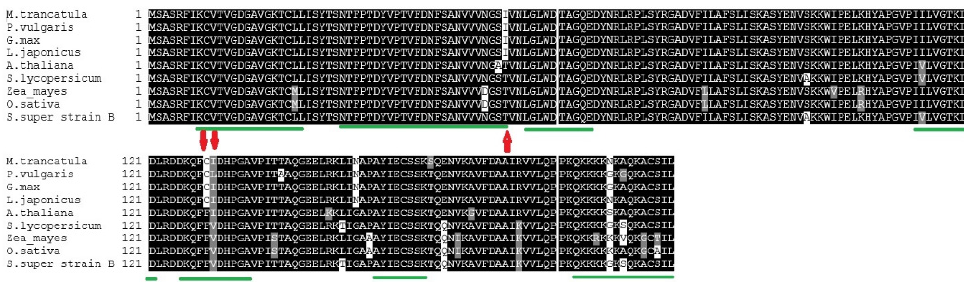
Figure 3. Multiple sequence alignments and the proteins of S. lycopersicum super strain B (ROP9) and those retrieved from the genomic databases: A. thaliana (At2g17800), O. sativa (LOC_Os02g58730), S. lycopersicum (Solyc02g083580), Z. mays (GRMZM2G375002), L. japonicus (chr2.CM0272.860.r2.m), M. truncatula (Medtr4g064897), P. vulgaris (Phvul.002G106600), and G. max (Glyma01g36880). Black boxes represent the identical residues while gray ones represent conservative substitutions. Align- ments were performed with Clustal Omega in MEGA7 followed with Boxshade. The red arrow des- ignates a conservative amino acid substitution in legume against non-legume sequences. The con- served domains of Rabs were indicated by green lines. The conserved domains of ROPs were indi- cated by green lines. By aligning the sequence of ROP10 proteins of all the species studied, we found the presence of 4 domains. ROP10 protein alignments also possessed substitutions in legume species (Figure 4), but only one of those swaps affects the ROP domain. This substitution was at the beginning of III, where leucine was found in P. vulgaris and G. max , valine in M. truncatula , L. japonicas , S. lycopersicum and Z. mays , and isoleucine in A. thaliana , O. sativa and S. lycopersicum super strain B. Figure 4. Multiple sequence alignments and the proteins of S. lycopersicum super strain B (ROP10) and